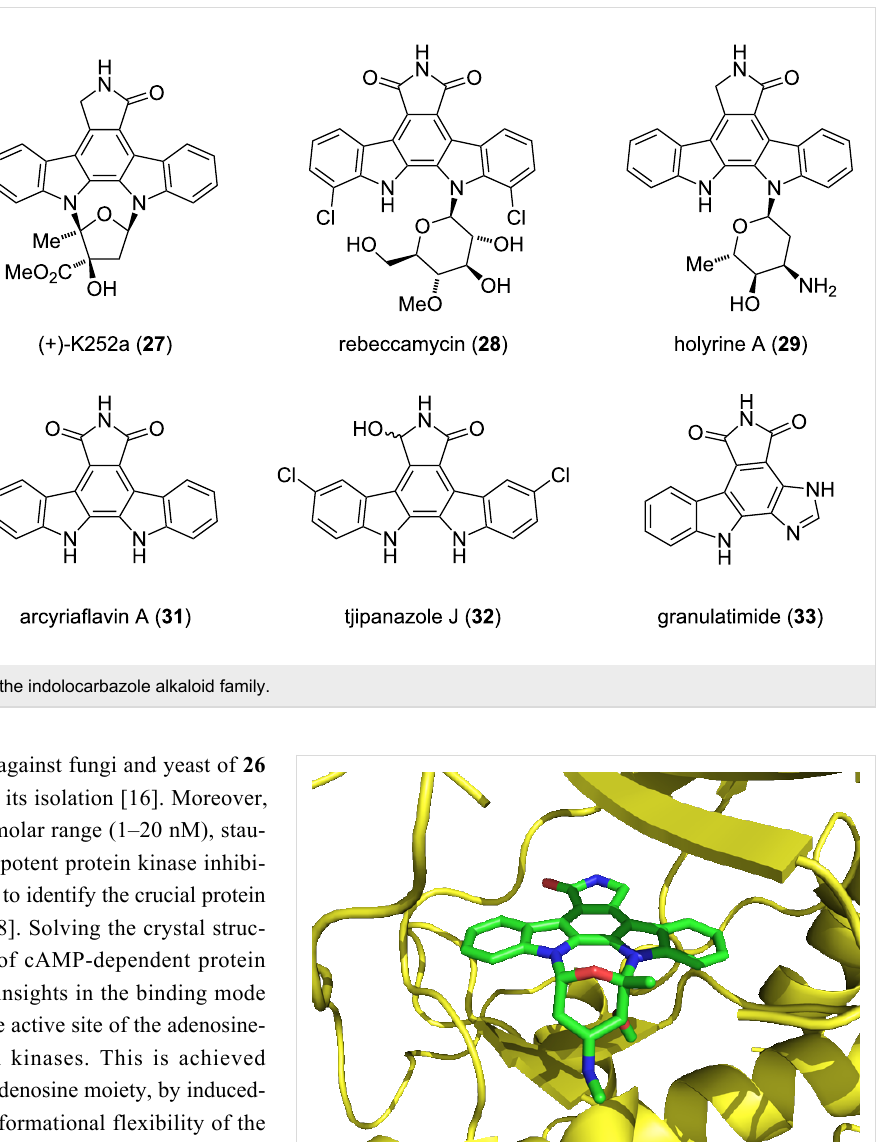
Figure 3: Staurosporine ( 26 ) bound to the adenosine-binding pocket [19] (from pdb1stc).